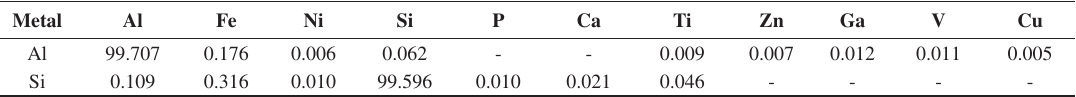
Table 1. Chemical compositions (wt. pct) of metals used to prepare the Al-3wt.%Si